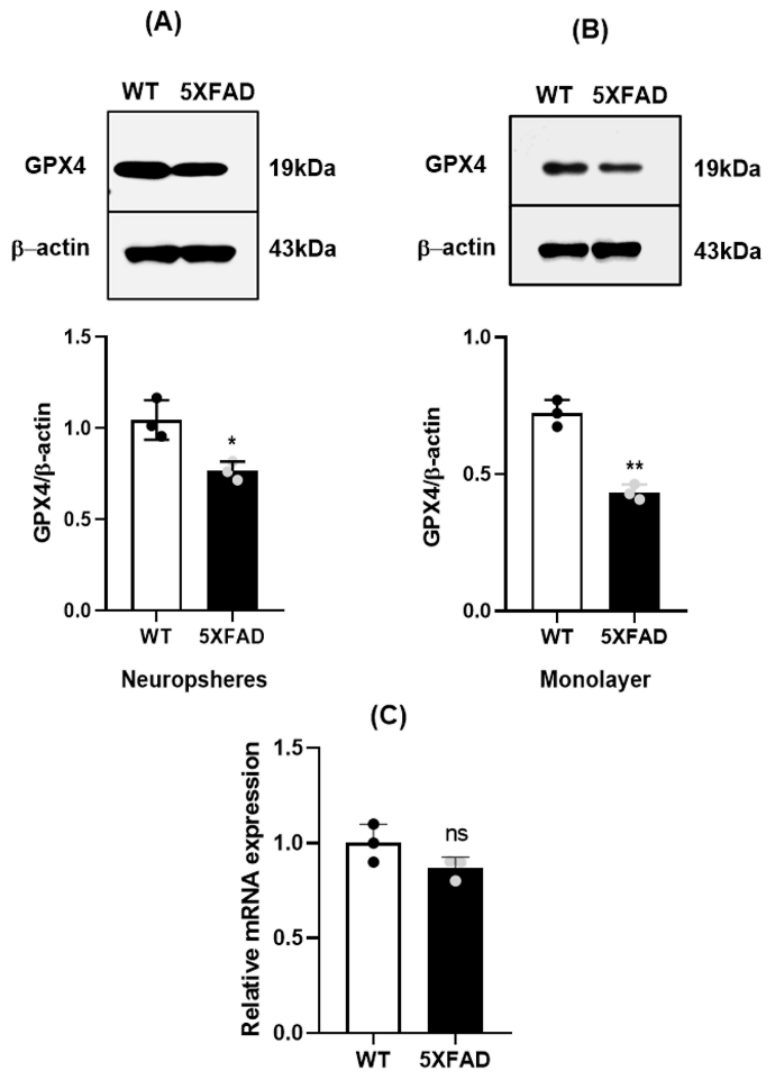
Figure 2. Decreased Gpx4 levels in in 5 × FAD NSCs ( A ). Western blot and densitometric analysis indicating decreased levels of Gpx4 in 5 × FAD NSCs grown as neurospheres. *: p <0.05. ( B ). Western blot and densitometric analysis indicate the decreased levels of Gpx4 in 5 × FAD NSCs grown as monolayers. **: p <0.01. ( C ). Relative mRNA levels of Gpx4 in 5 × FAD and WT NSCs. ns: not significant.